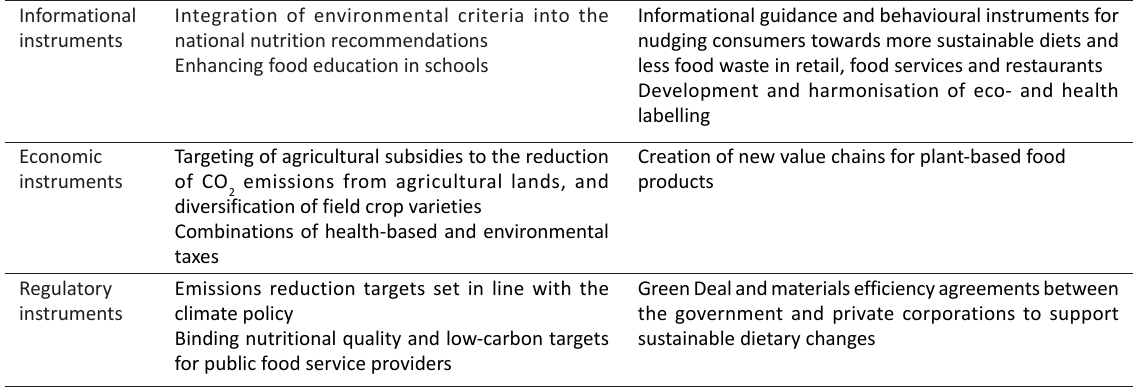
Table 2. Policy mixes for sustainable dietary change suggested by the actors in the Finnish food system Informational